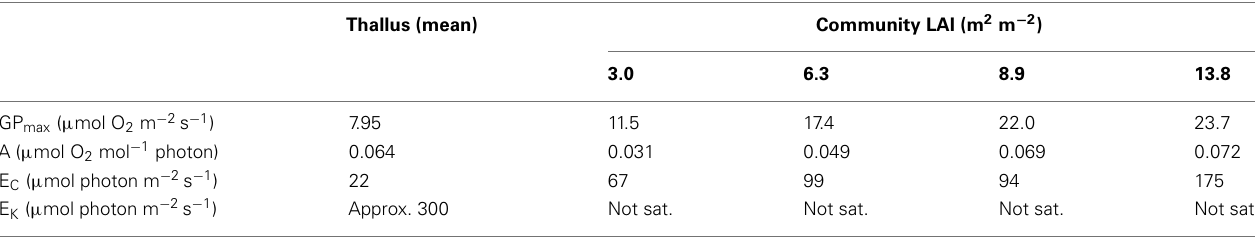
Table 1 | Photosynthetic parameters for thallus segments and communities of Fucus serratus of varying leaf area index (LAI).